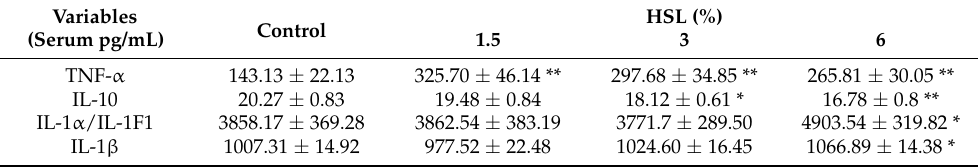
Table 3. Proinflammatory markers in serum in the rats of the experimental groups.